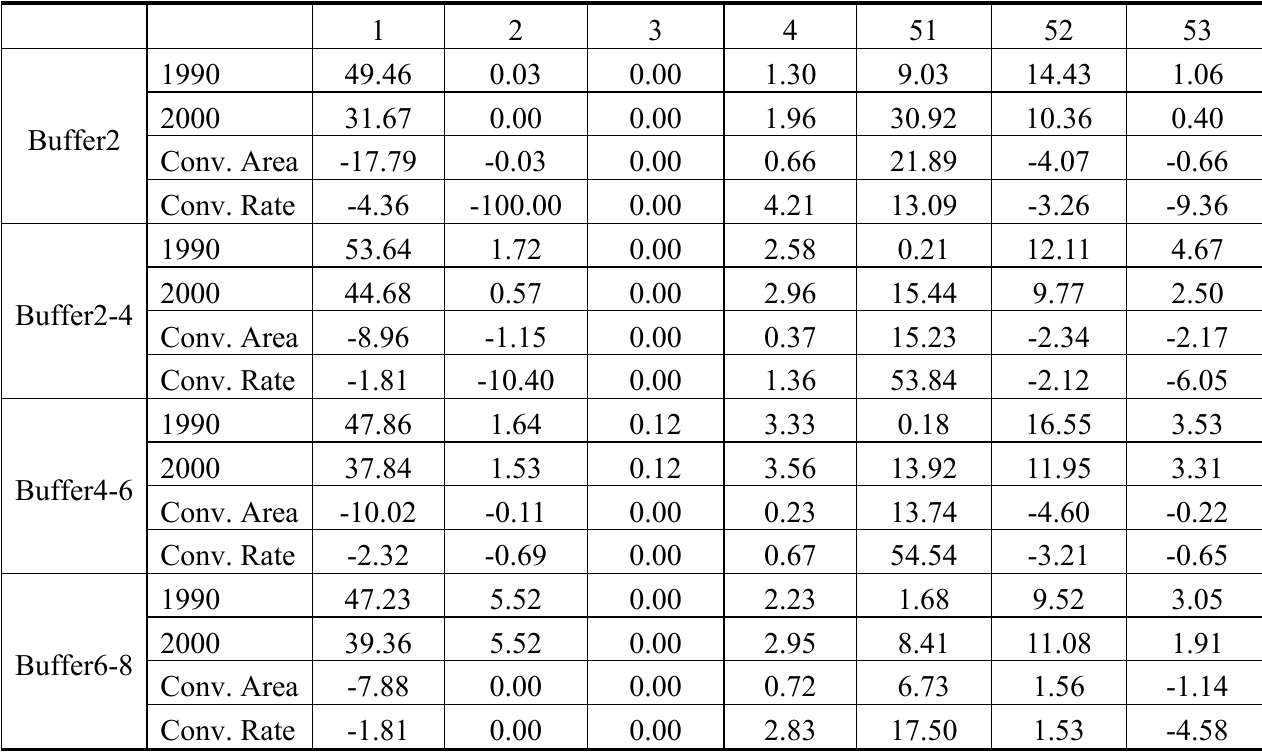
Table 6. Land use changes in the buffered belts